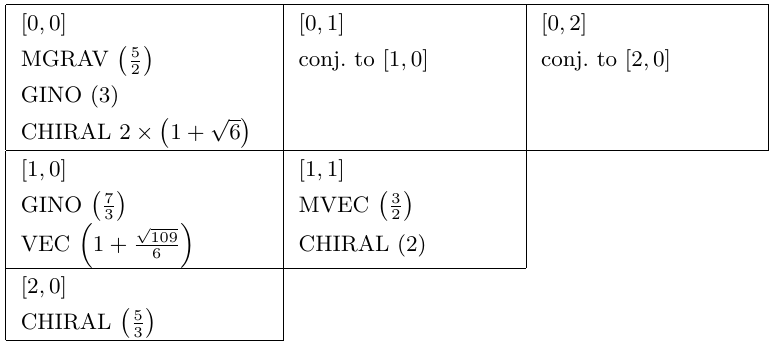
Table 12 . Supermultiplets at KK level n = 0 for the N = 1 SU(3)-invariant AdS 4 solution of type IIA.